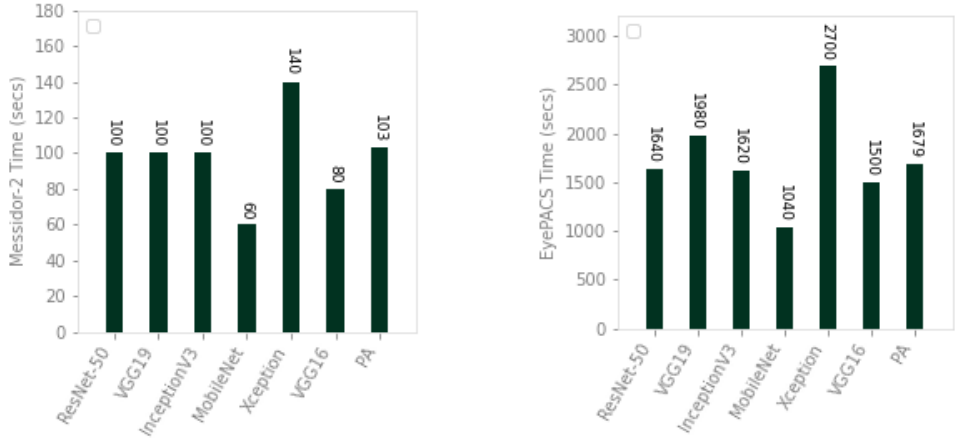
Figure 6. Comparison of existing approaches and proposed approach in terms of execution time (training and testing) on Messidor-2 ( left ) and EyePACS ( right ) datasets using 10-fold cross